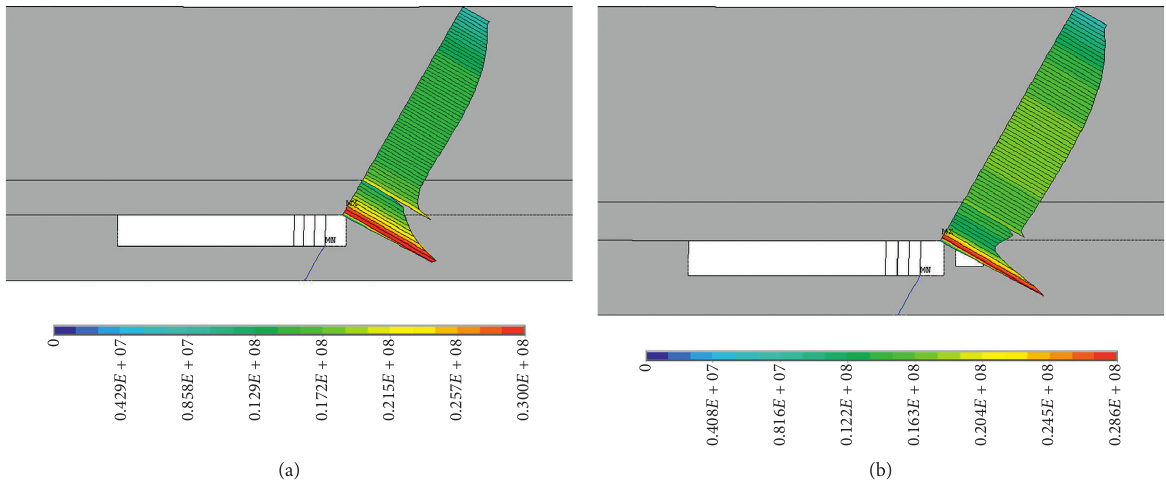
Figure 25: The nephogram of contact pressure when work face is under the fault (reverse direction fault). (a) Without searching tunnel. (b) With searching tunnel.